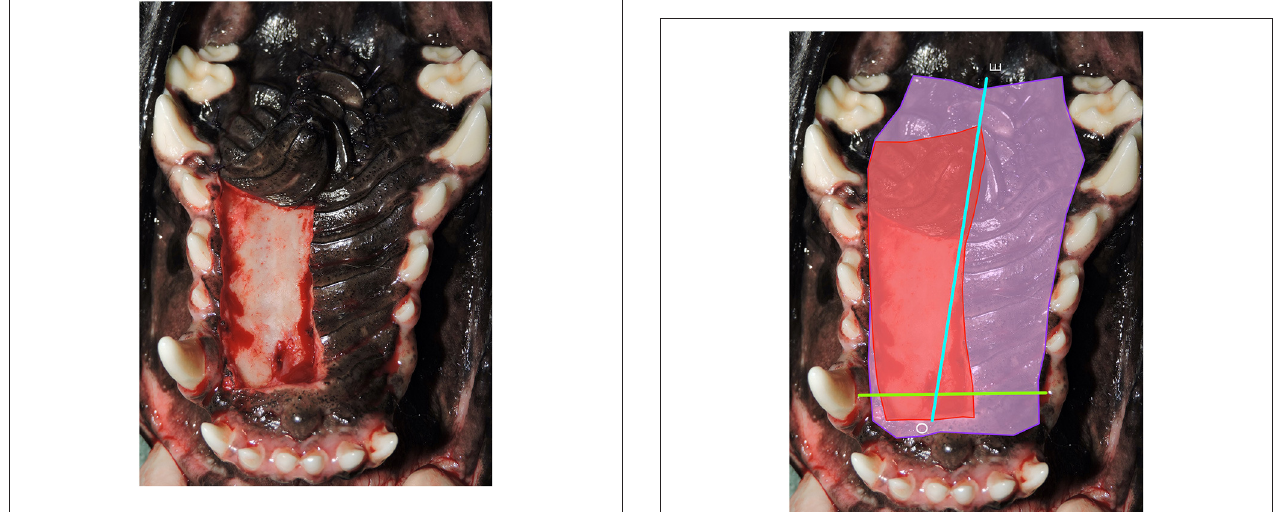
FIGURE 1 | Example photograph of final closure used for all measurements. A single, clear photograph from each case showing the entire hard palate and hard palate mucoperiosteal flap (HPF) is used to make all computerized measurements for estimation of the total hard palate area, flap size, and distance traveled by the HPF.